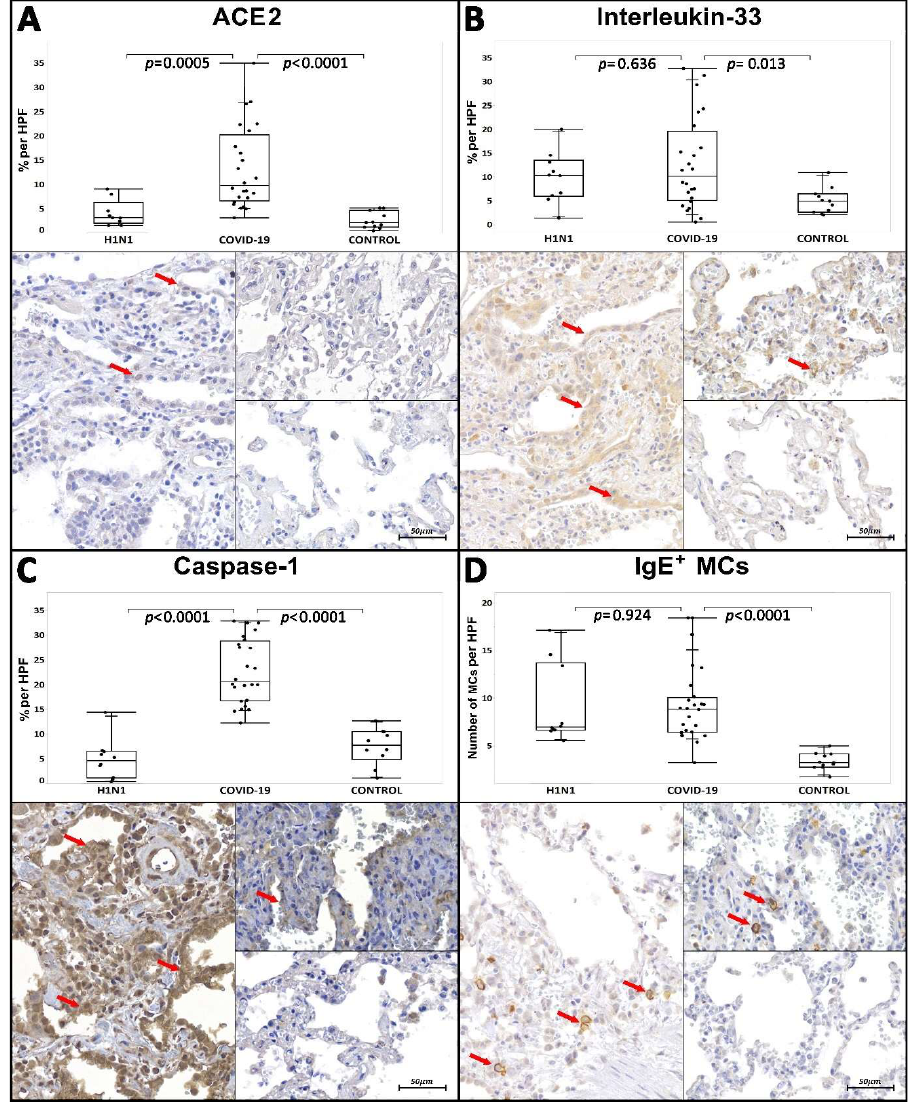
Figure 1. Graphics show comparison between COVID-19 (left images), H1N1 (right upper images) and CONTROL (right lower images), regarding ACE2, Interleukin-33 and Caspase-1 in the percentage of immunoexpression per HPF (high power field) and the density of IgE + MCs per HPF. ( A ) ACE2 showed mild positive immunostaining (red arrow) in the alveolar epithelium of the COVID-19 group. However, there was a significant statistical increase compared to the H1N1 and CONTROL groups. ( B ) Tissue expression of Interleukin-33 (red arrow) appeared higher in patients in the COVID-19 group when compared to the CONTROL group; however, it was not statistically increased compared to the H1N1 group. ( C ) The tissue expression of Caspase-1 (red arrow) was increased in the COVID-19 group when compared to the H1N1 and CONTROL groups, demonstrating a larger significant presence of pyroptosis by SARS-CoV-2 infected cells. ( D ) Regarding the density of IgE + MCs, the COVID-19 group presented an increase in the number of MCs opsonized by IgE (cells highlighted by red arrows) when compared to the CONTROL group. However, there was no statistical difference compared to the H1N1 group. Images were scanned using the Axio Scan Z1 slide scanner (Zeiss, Jena, Germany) at 40 × magnification. Mann–Whitney nonparametric test. Values of p < 0.05 indicated statistical